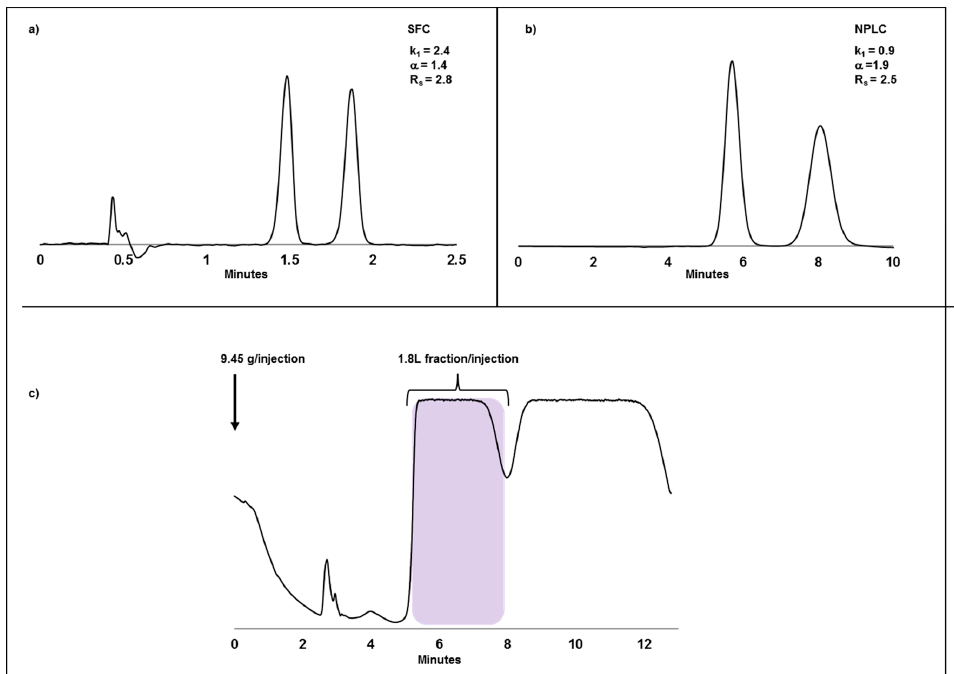
Figure 1. Chiral separation of a basic compound A . ( a ) Analytical SFC chromatogram using a Chiralpak IA 150 mm × 4.6 mm, 3 µm column. Mobile phase was 15% methanol/dichloromethane/diethyl amine 50/50/0.5 (v/v/v %) in CO 2 at 40 °C, 120 bar and a flow rate of 4 mL/min; ( b ) Analytical NPLC chromatogram using a Chiralpak IA 250 mm × 4.6 mm, 20 µm column. Mobile phase was heptane/ethyl acetate/diethyl amine 50/50/0.5 (v/v/v %) at a flow rate of 1 mL/min; ( c ) Preparative chromatogram on Chiralpak IA 250 mm × 110 mm, 20 µm. 9.45 g (270 mg/mL dichloromethane)